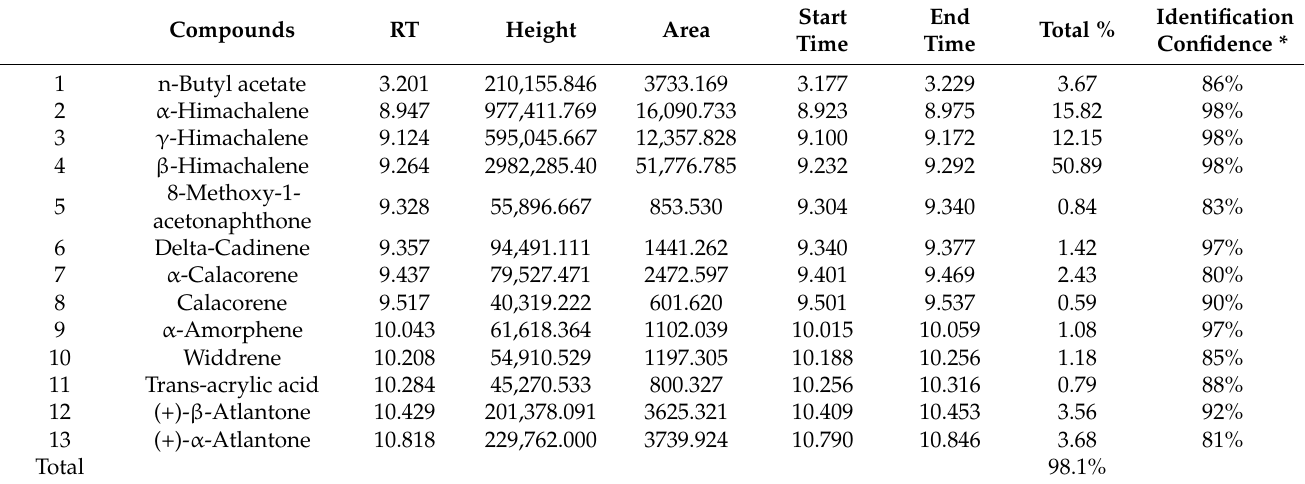
Table 1. Cedarwood phytochemical components.